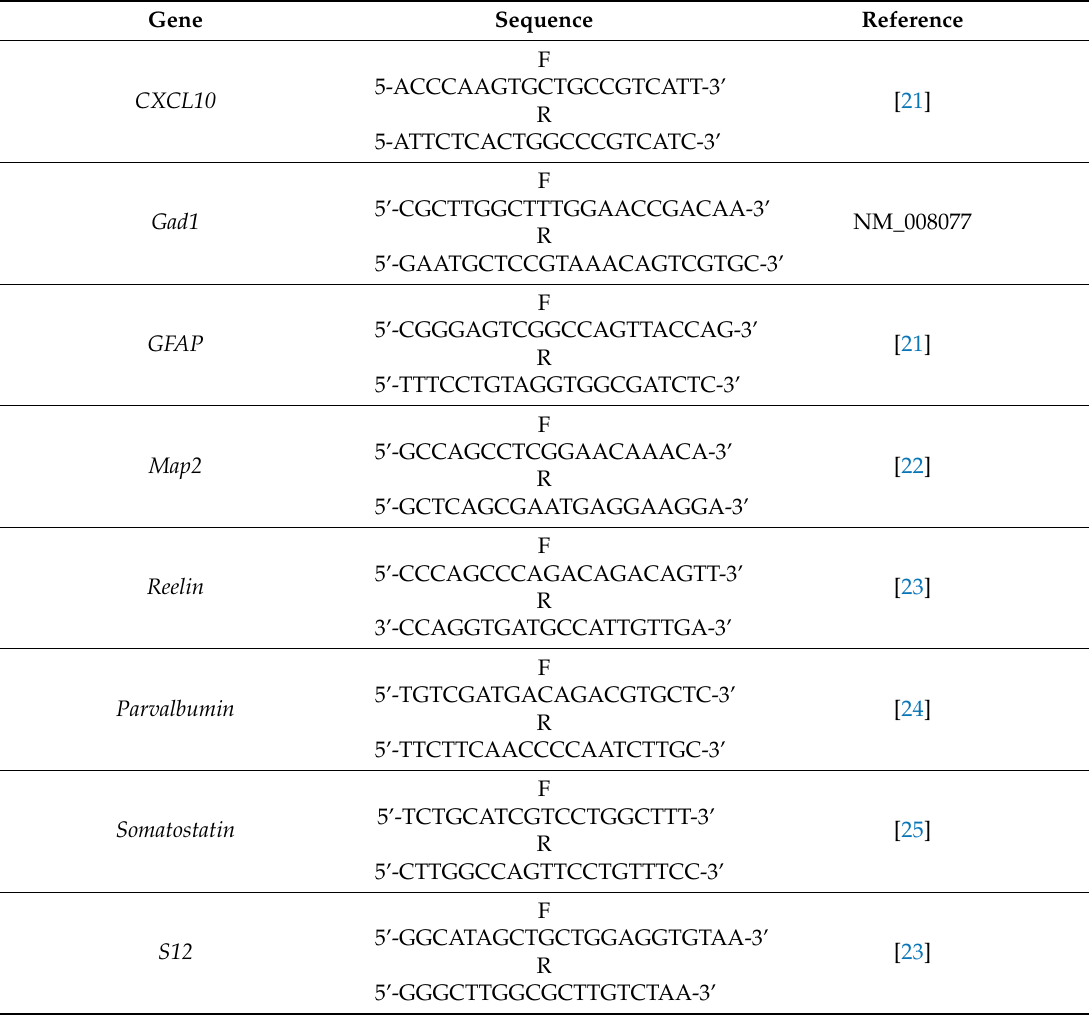
Table 1. Primers used for RT-qPCR analysis. F = Forward. R =